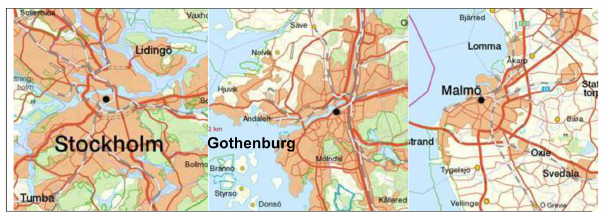
Figure 1. Stockholm, Gothenburg, and Malmö: the three largest cities in Sweden, and their surroundings. The black dot in each city shows the location of the measuring station. Each map represents an area of 35 ×